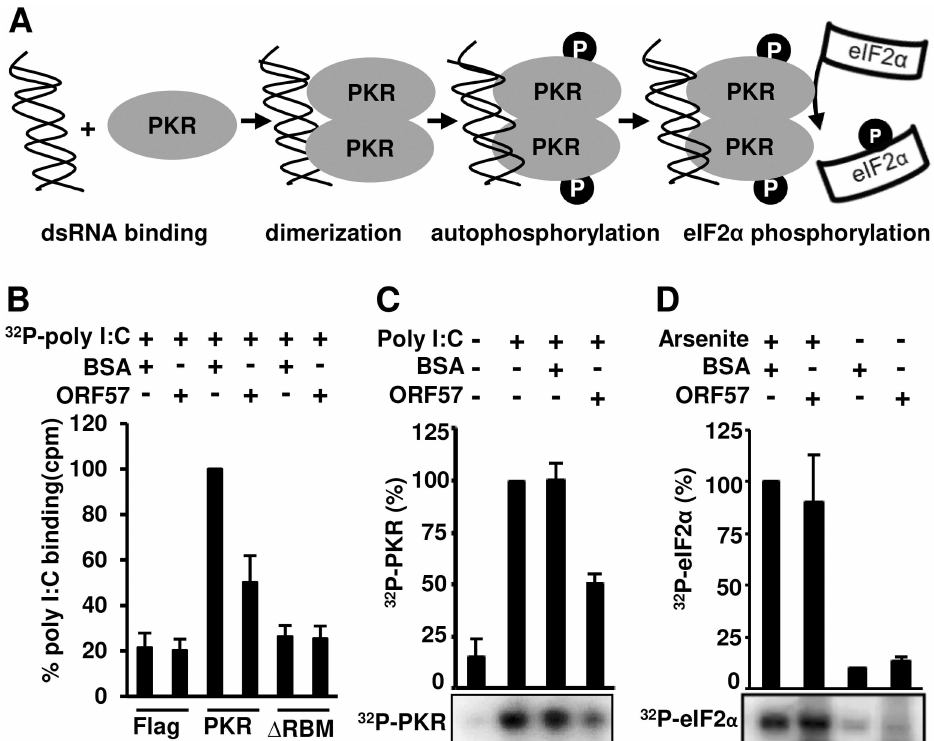
Fig 8. ORF57 inhibits autophosphorylation of PKR by blocking its interaction with Poly I:C, but does not directly affect elF2 α phosphorylation. (A) Schematic diagrams of PKR activation. PKR binds to dsRNA poly I:C leadingto its dimerization and autophosphorylation.The phosphorylated PKR at the kinase domain catalyzes eIF2 α phosphorylation. (B) ORF57 interacts with PKR and prevents PKR from bindingto poly I:C. Purified PKR-Myc-Flag or its mutant Δ RBM (Fig 7A) immobilized on Myc beads was incubatedwith ORF57 or BSA for 15 min at room temperature before additionof 32 P-poly I:C. Bar graphswith means ± SD (n = 4, each in triplicate) show the bindingof 32 P-poly I:C to PKR or its Δ RBM mutant in the presenceof ORF57 or BSA, quantified by scintillation count. Flag peptideadditionto Myc beads served as a negativecontrol for the Myc beadsonly (no immobilizedPKR protein). (C) ORF57 inhibits PKR autophosphorylation. Purified PKR-Myc- Flag on Myc beads was used in the assay in the presenceof [ γ - 32 P-ATP], with or without poly I:C or with poly I:C plus ORF57 or BSA. The incorporated 32 P into PKR due to autophosphorylationinducedby poly I:C bindingwas measuredby autoradiographyof a SDS-PAGE gel after normalized to BSA control. The bar graph with means ± SD is derived from three independentexperiments, with a representative SDS-PAGE gel image shown below the bar graph. (D) ORF57 doesn’tdirectly affect eIF2 α phosphorylation. Inactive or arsenite-activated PKR-Myc-Flag immobilizedon Myc beads was mixed with ORF57 or BSA protein and followedby addition of GST-eIF2 α . An in vitro kinase reactionin the presence of [ γ - 32 P-ATP] was carried out to phosphorylate GST-eIF2 α . Incorporated 32 P into GST-eIF2 α was measuredusing SDS-PAGE and followedby autoradiography.The bar graph with means ± SD is derived from three independentexperiments, with a representative SDS-PAGE gel image shown belowthe bar